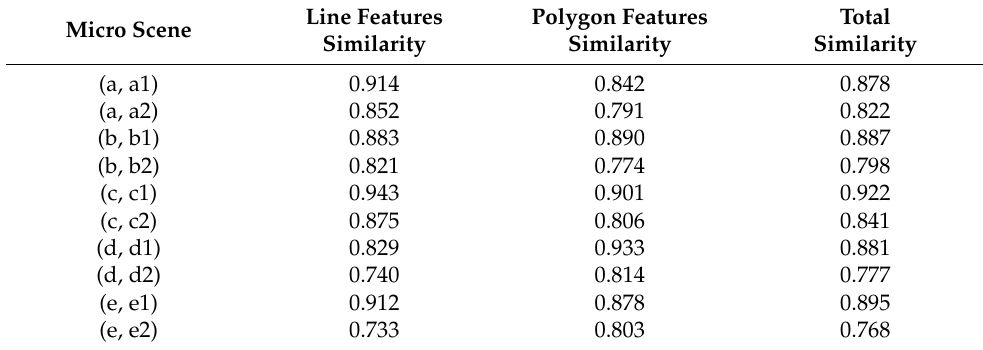
Table 3. Calculation results of Fourier shape